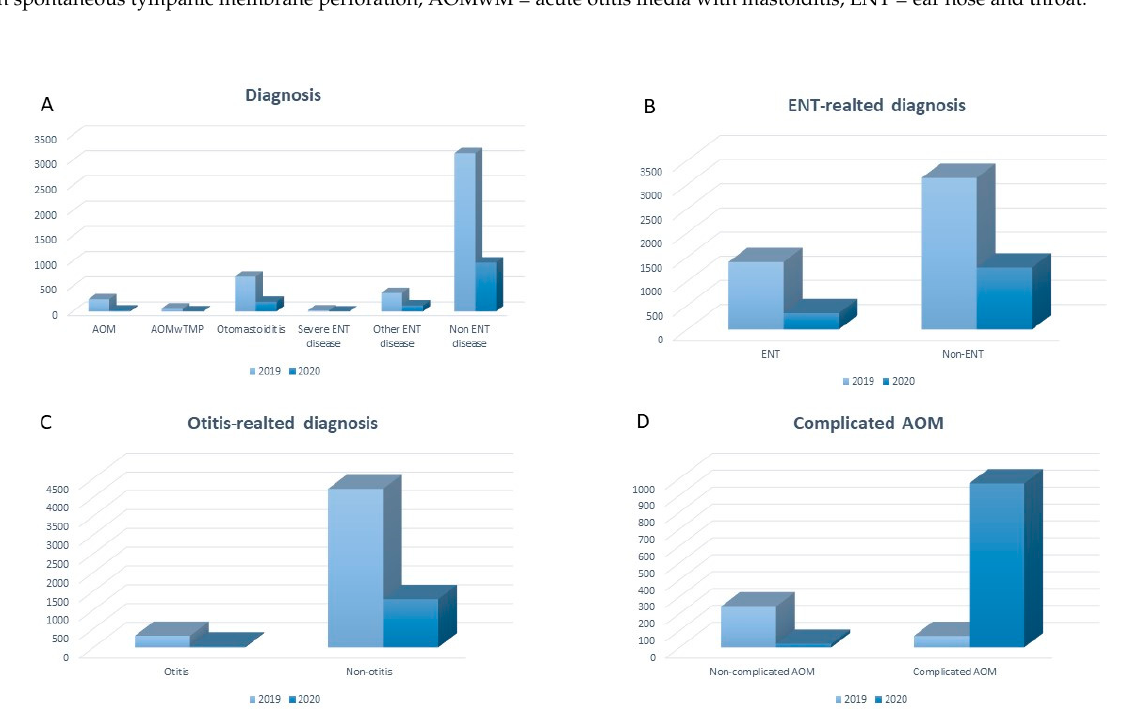
Table 2. Demographic and clinical characteristics of the population.